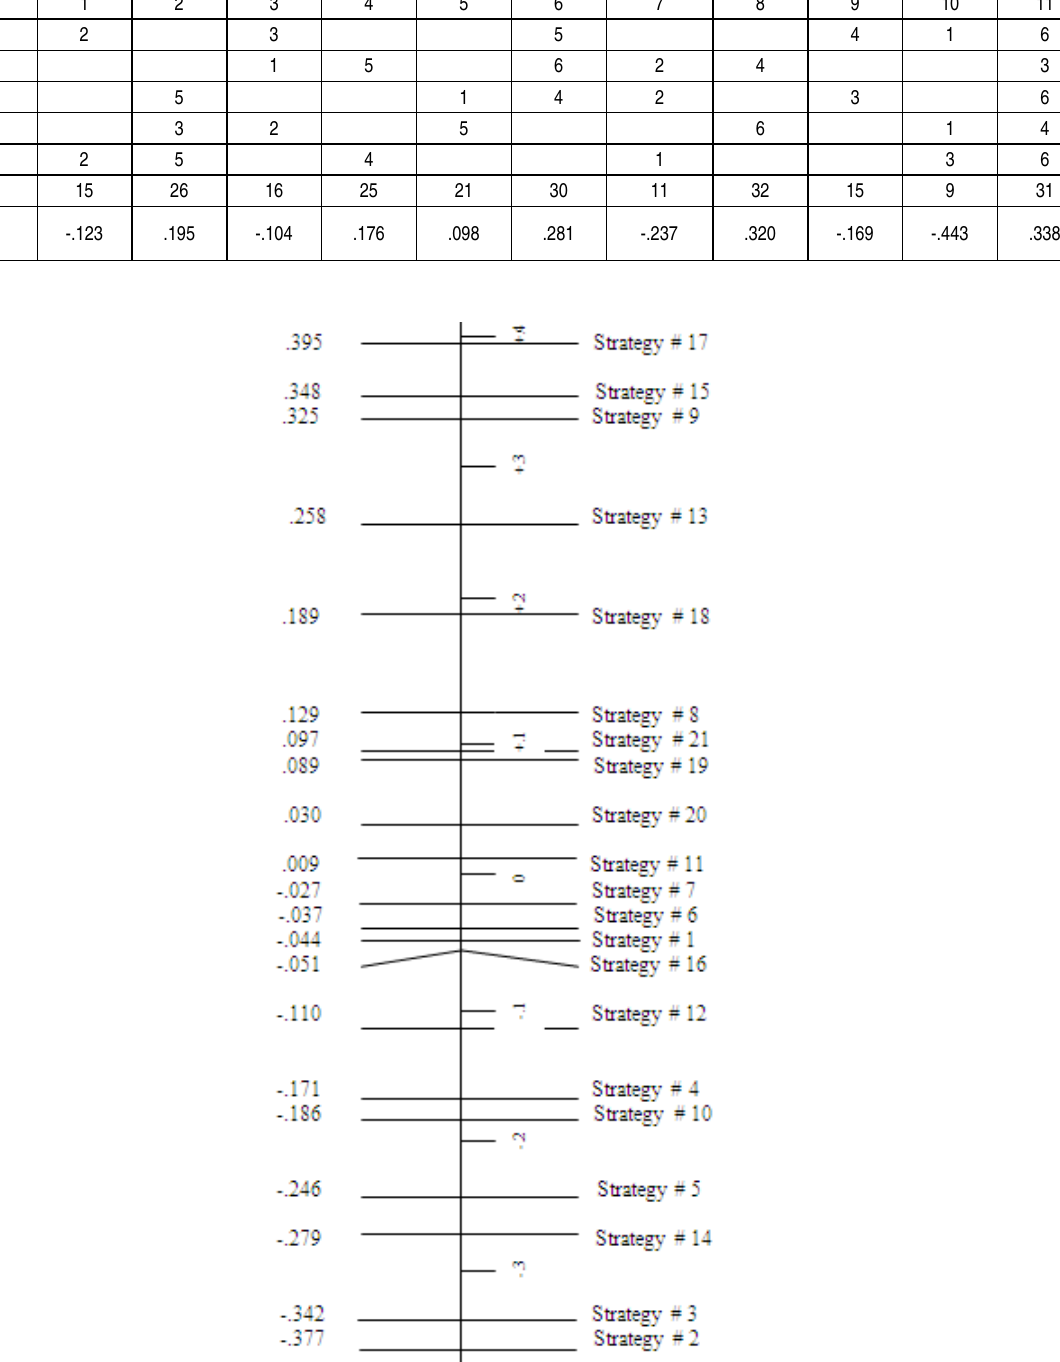
Table 8 (cont.). Results from BIBD for distribution center location preference study Top mgmt. number